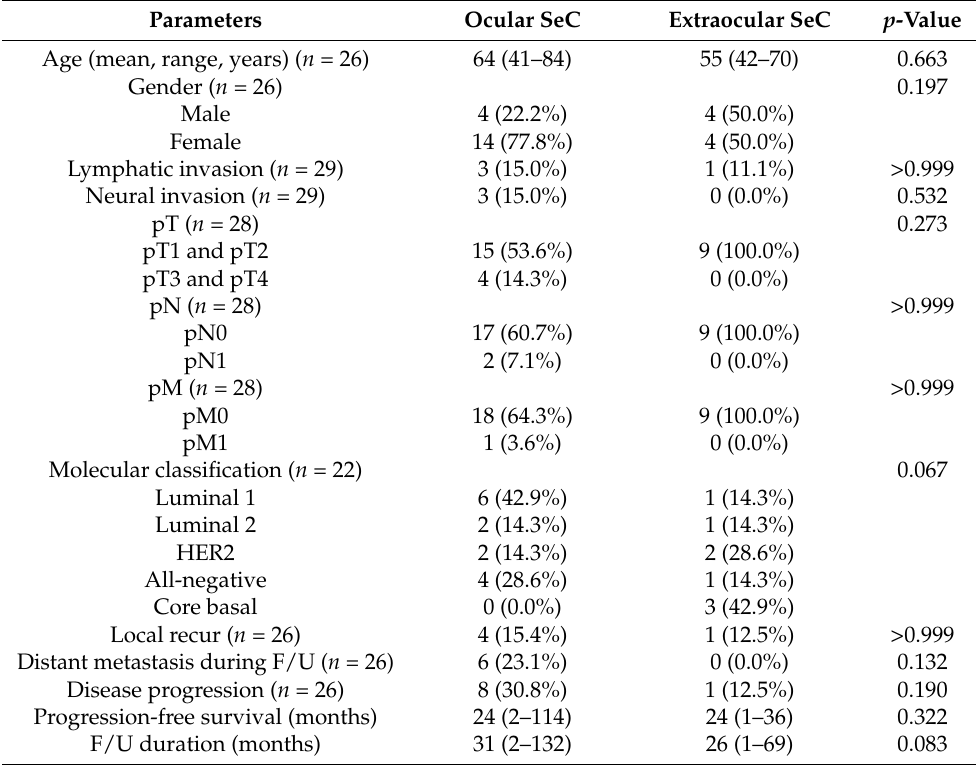
Table 1. Clinicopathological parameters of ocular and extraocular sebaceous